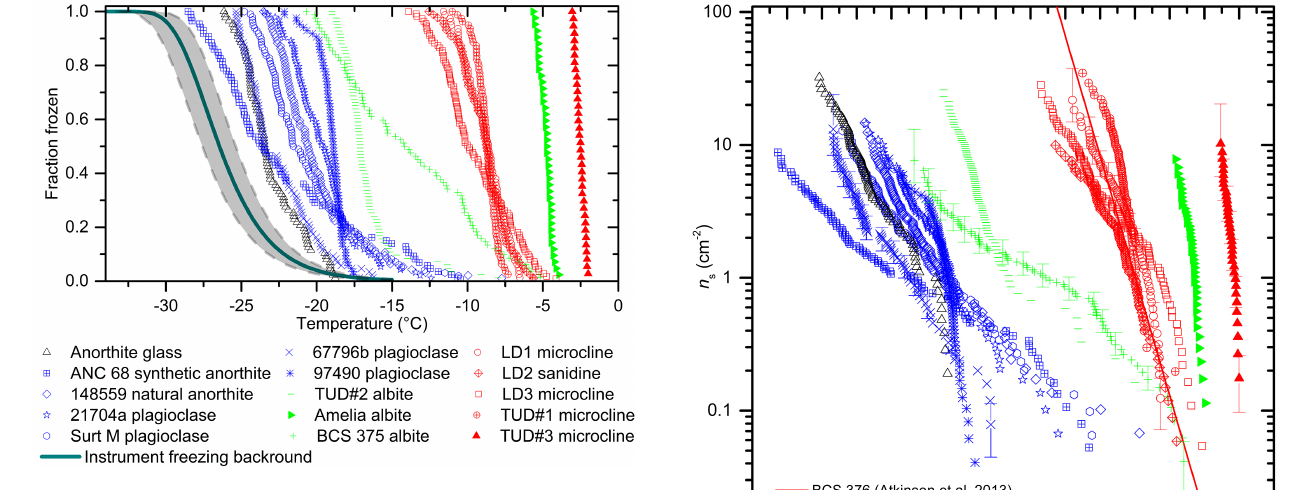
Figure 2. Droplet fraction frozen as a function of temperature for 1 wt% suspensions of ground powders of various feldspar sam- ples. The K-feldspars are coloured red, the plagioclase feldspars are coloured blue, the albites are coloured green and the feldspar glass is coloured black. A fit to the background freezing of pure MilliQ water in theµl-NIPI instrument used by Umo et al. (2015) is also included. The shaded area around this fit shows 95% confidence in- tervals for the fit. It can be seen that all the feldspar samples tested nucleate ice more efficiently than the background freezing of the instrument.